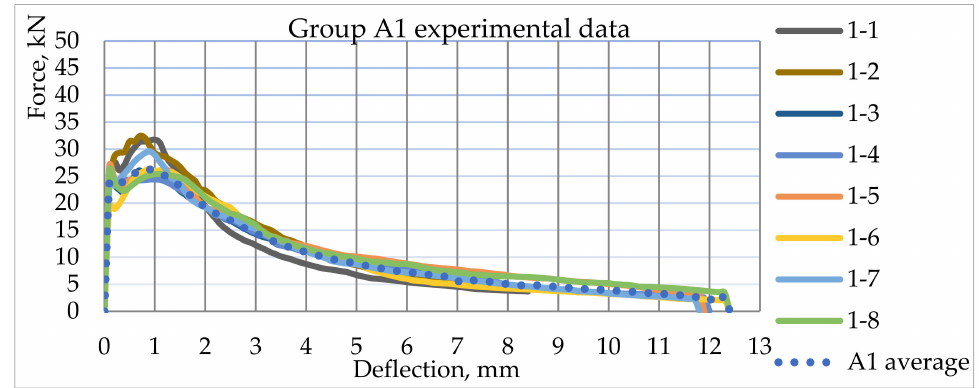
Figure 15. Load—sample center vertical deflection graphs for the specimens in the reference Group